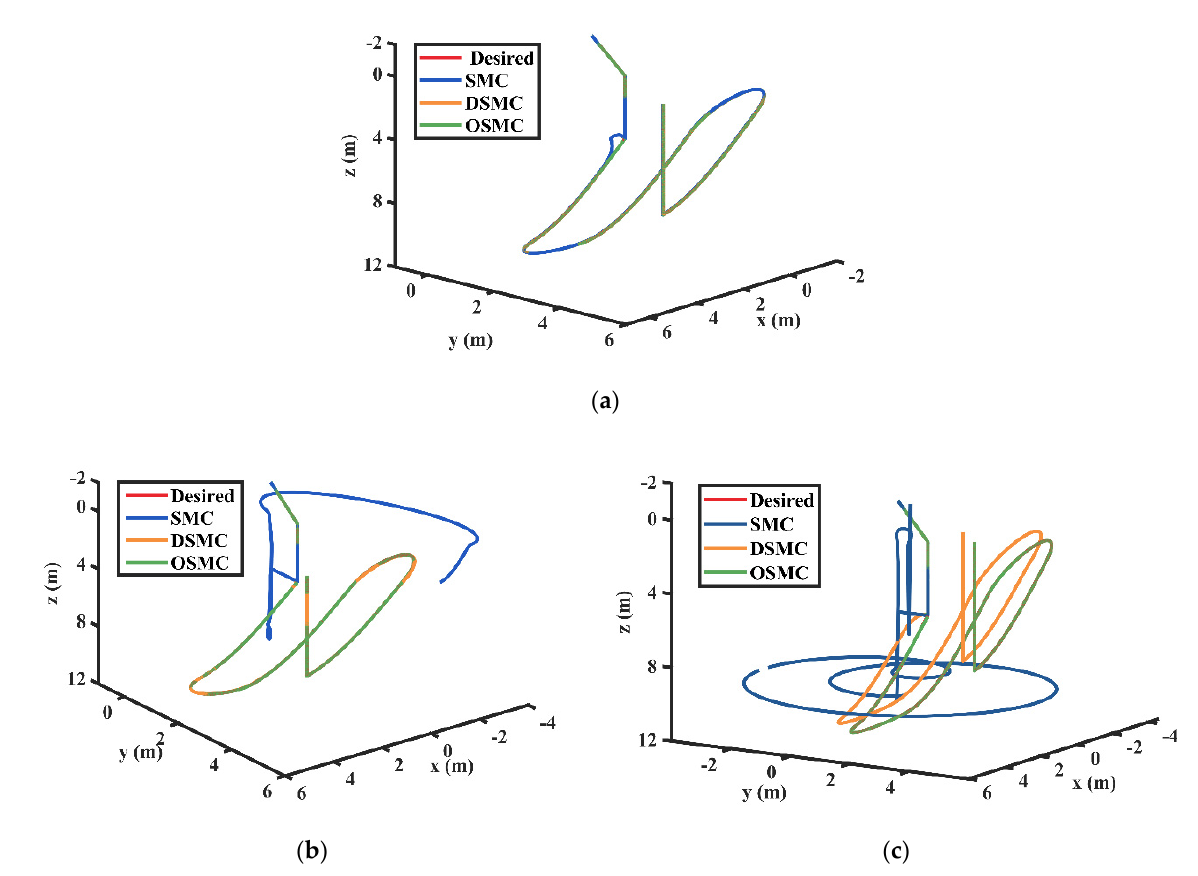
Figure 7. The 3D trajectory tracking results of the ROV under different ocean current conditions: ( a ) trajectory tracking results under the condition of ocean current velocity of 2 m/s; ( b ) trajectory tracking results under the condition of ocean current velocity of 3 m/s; ( c ) trajectory tracking results under the condition of ocean current velocity of 4 m/s.